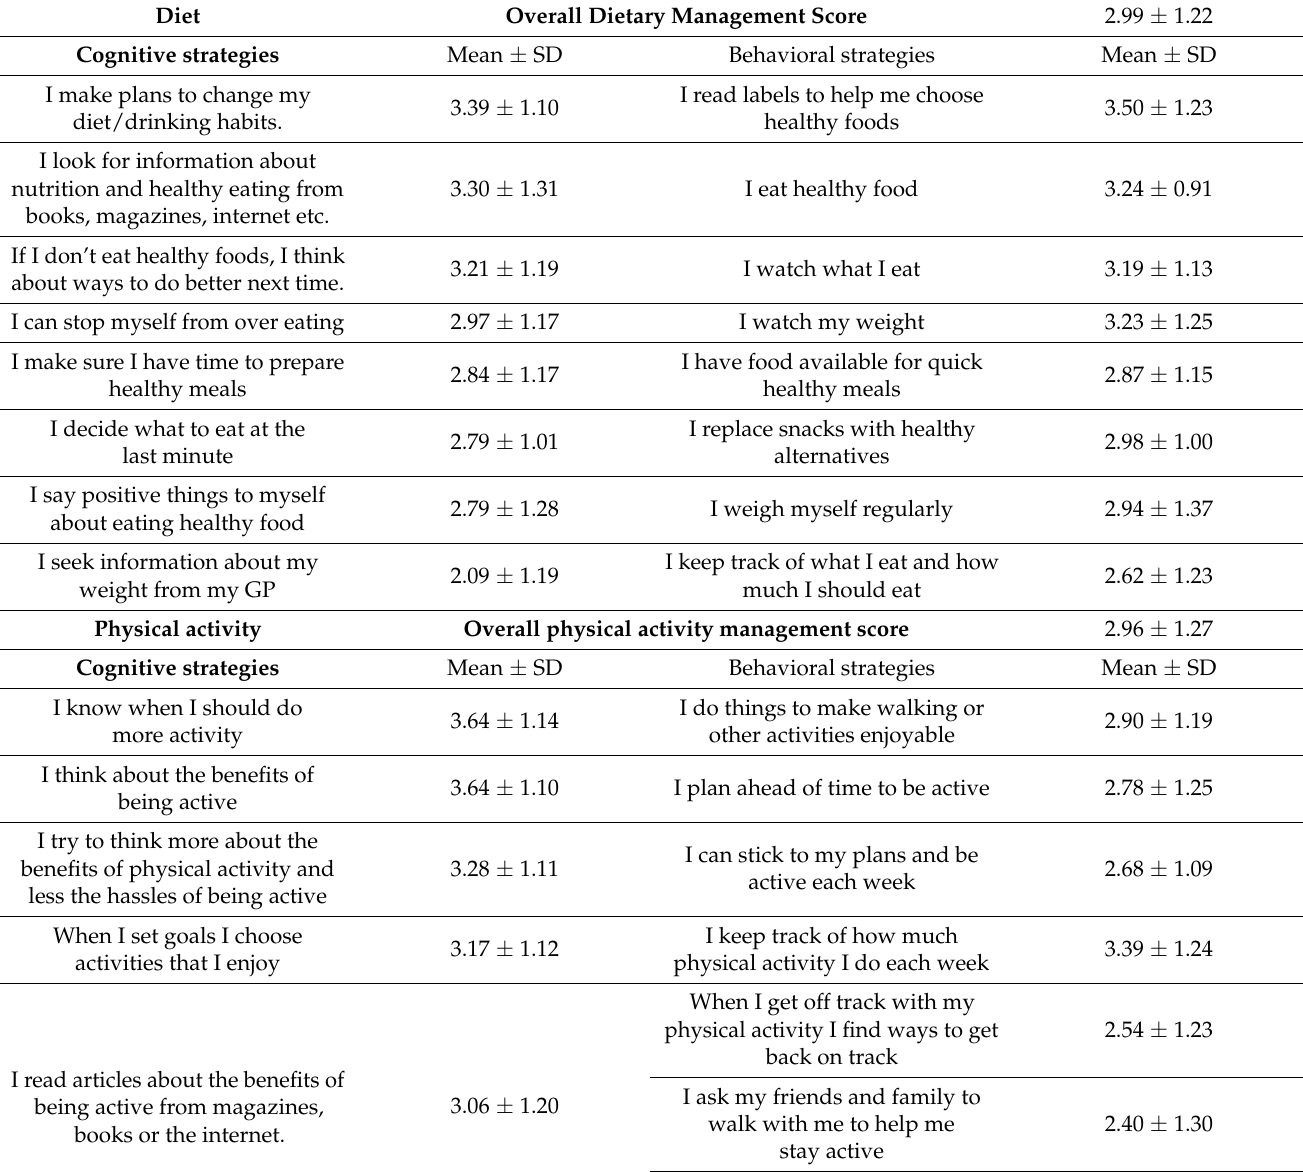
Table 4. Self-management strategies used among women with